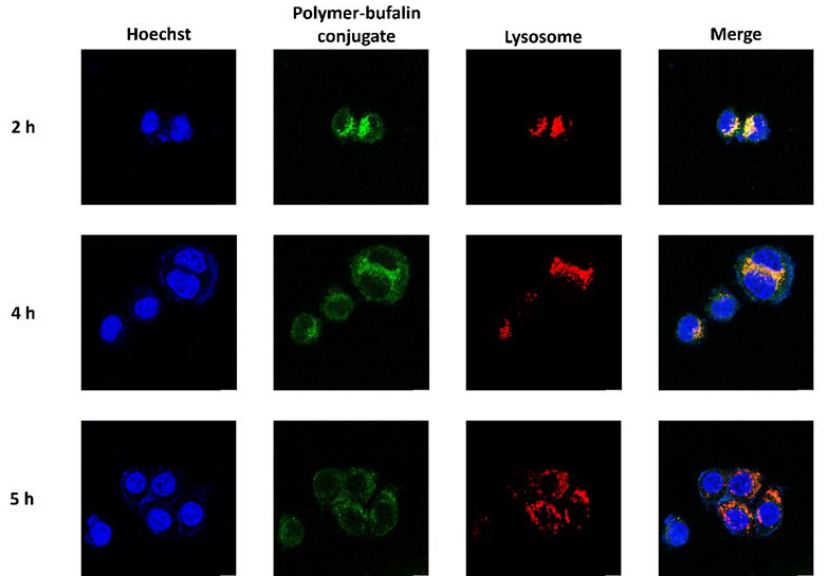
Figure 3. Visualization of cellular uptake of the polymer–bufalin conjugate P2. HepG2 cells were treated with polymer–buf conjugate P2 for 2, 4, and 5 h and analyzed by the confocal microscope. Scale bar = 100 μm. Scale bar = 100 µ